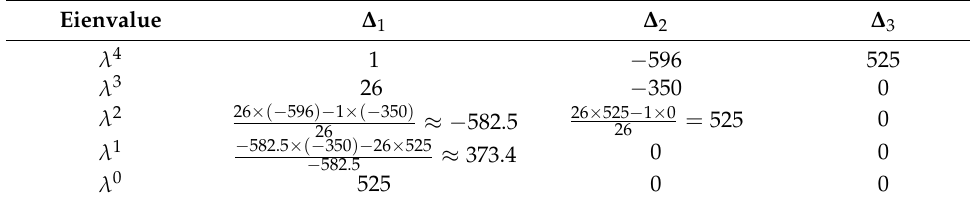
Table 1. System stability